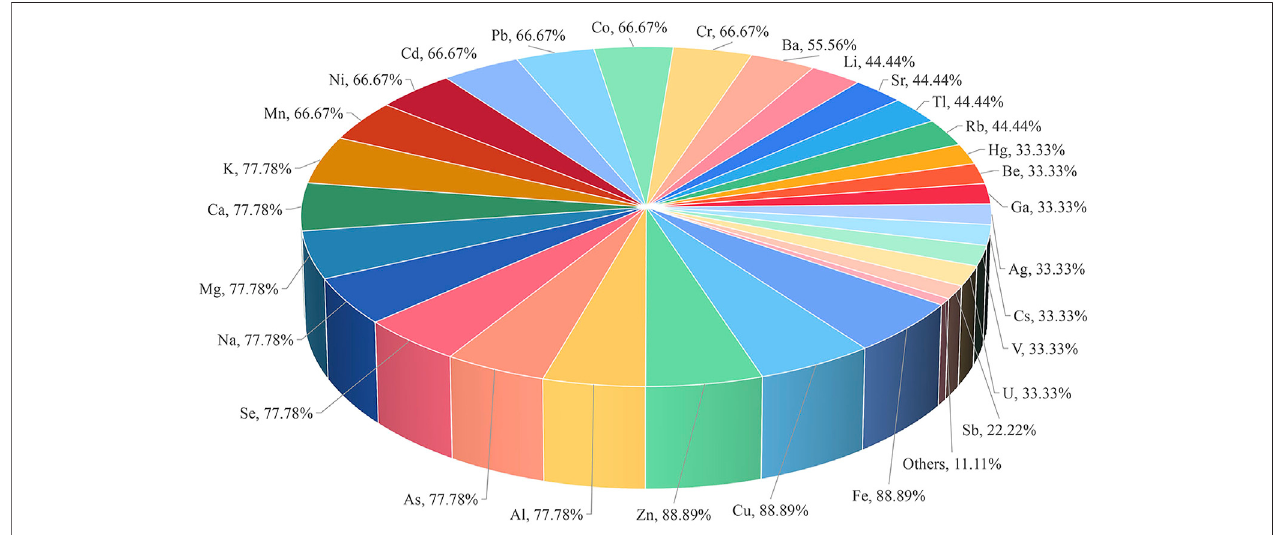
FIGURE 4 | Pie chart of elements measured by ICP-MS and their proportions in medicinal materials derived from minerals.